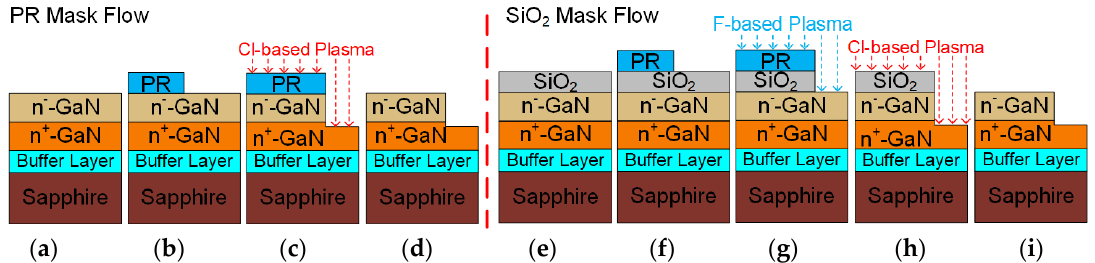
Figure 2. Fabrication steps of mesa etching with photoresist (PR) as a mask. ( a ) Epitaxial structure of the GaN sample; ( b ) PR mask on GaN; ( c ) chlorine-based mesa etching; ( d ) stripping of the PR. Fabrication steps of the SiO 2 -masked GaN mesa etching; ( e ) SiO 2 hard mask deposition on the GaN sample; ( f ) PR mask on SiO 2 ; ( g ) hard mask etching by fluorine-based plasma; ( h ) chlorine-based mesa etching; ( i ) Stripping of the SiO 2 hard mask.